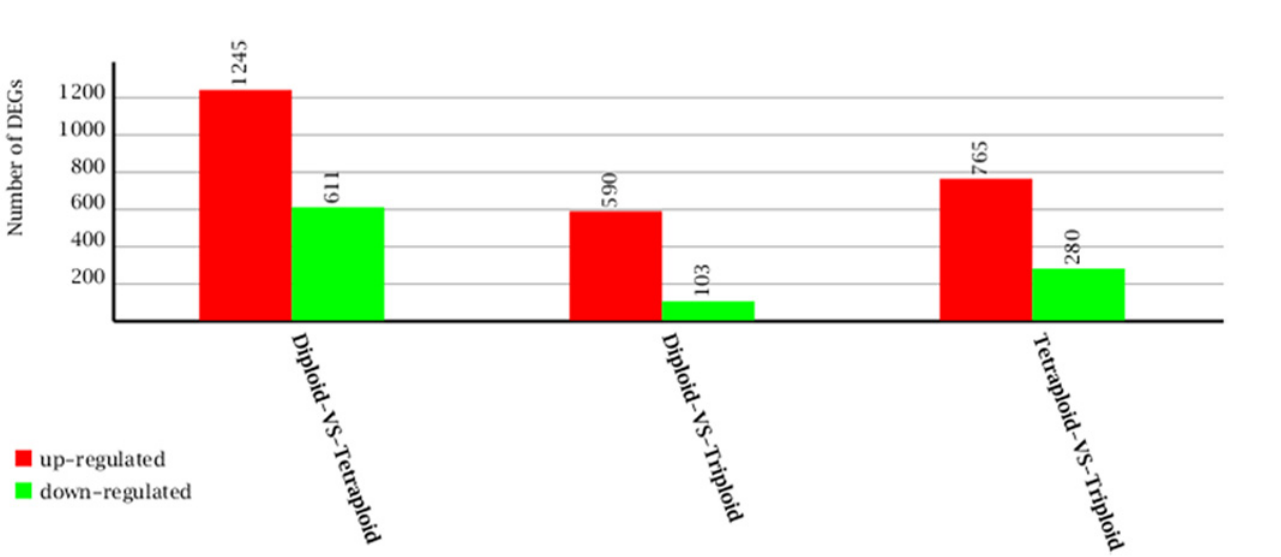
PLOS ONE | DOI:10.1371/journal.pone.0116392 March 4,